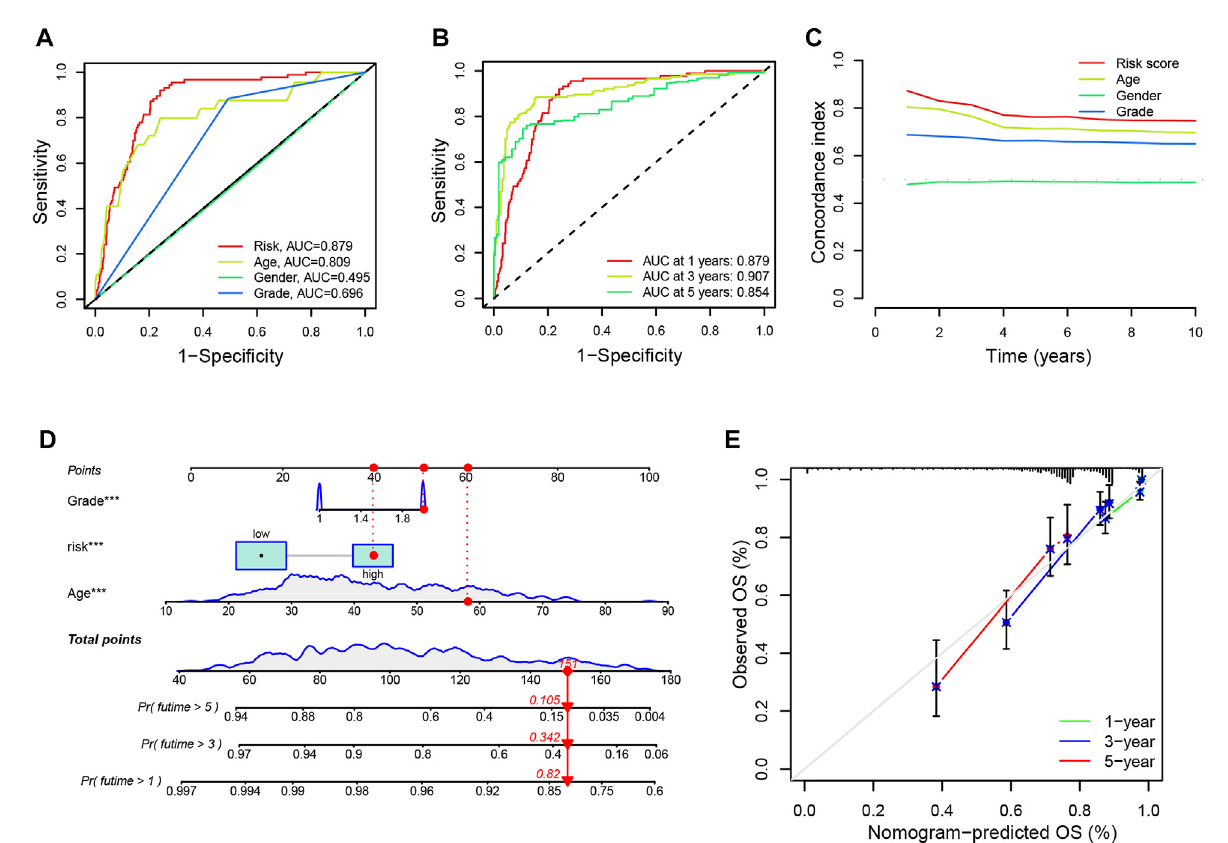
FIGURE 4 ROC curves and establishmentofanomogram (A) .The AUC values of theriskfactors include riskscores, age, gender and tumor grade (B) .The AUC of the CRL signature for 1-, 3-, and 5-year survival rates in glioma (C) . The concordance index of the risk factors including risk scores, age, gender, and tumor grade (D) . A nomogram predicting the 1-, 3- and 5-year survival rates for glioma using independent prognostic factors (grade, age, and risk score) (E) . Calibration curves show the concordance between the prediction by nomogram and actual survival. AUC, an area under the curve; CRL, cuproptosis-related lncRNA; OS, overall